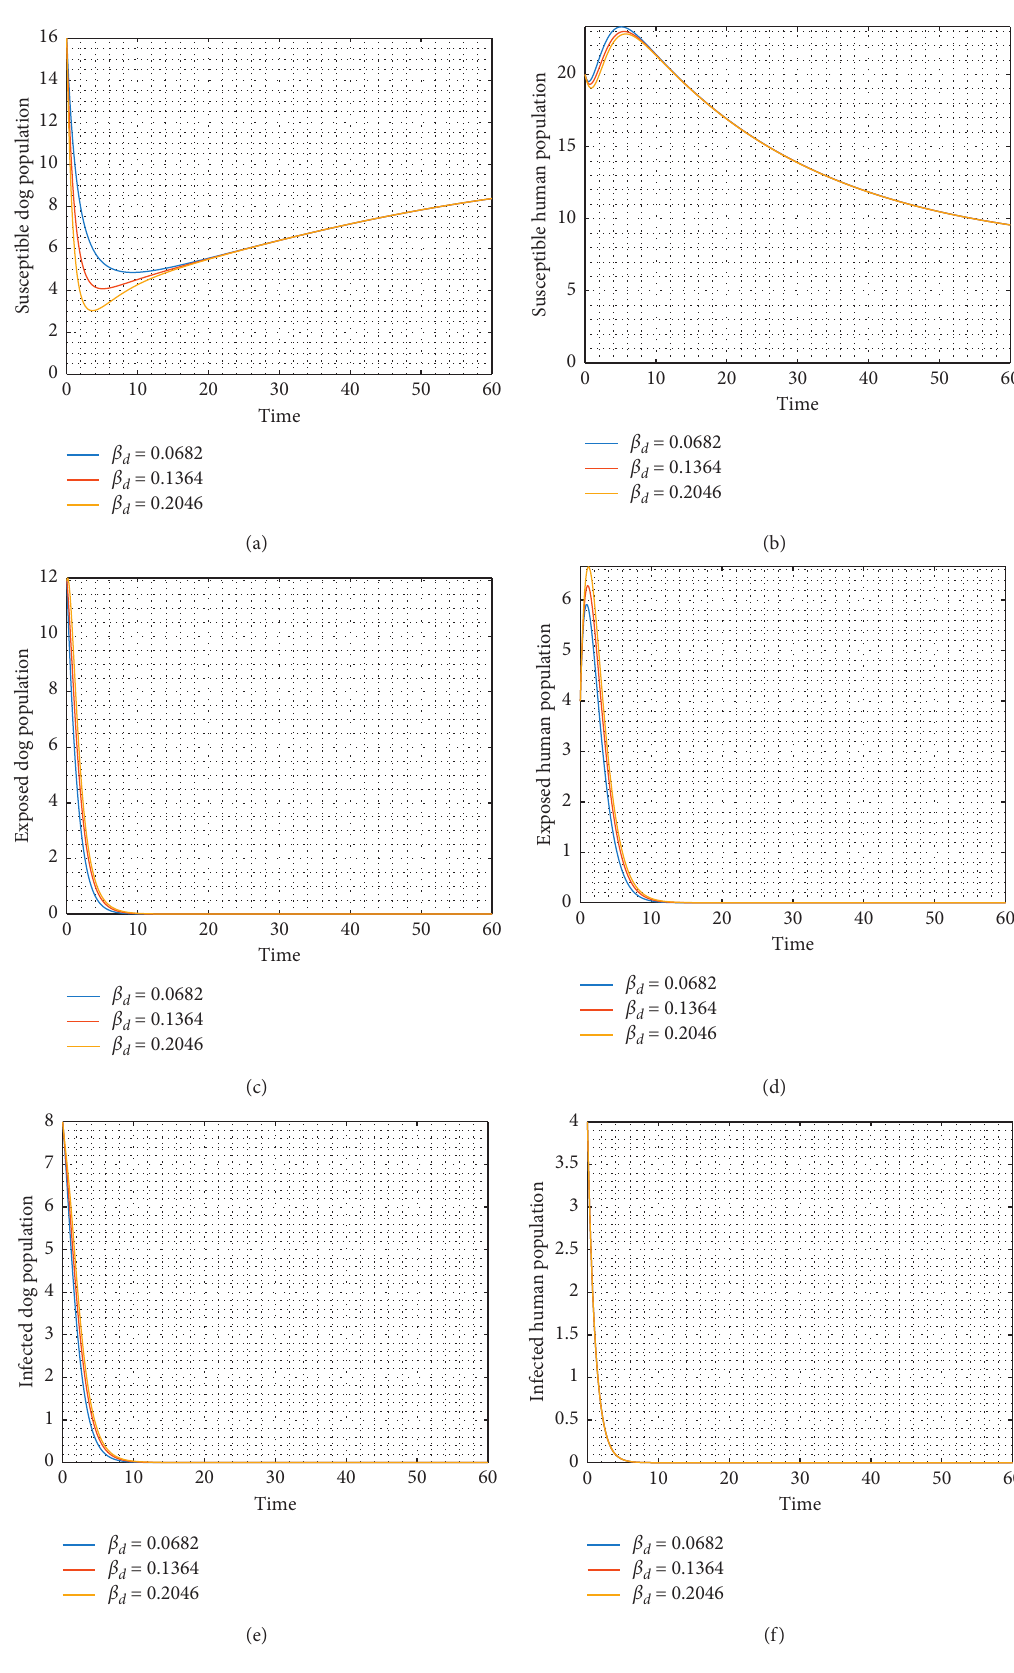
Figure 4: Solution curves of model (1) showing the effect of β